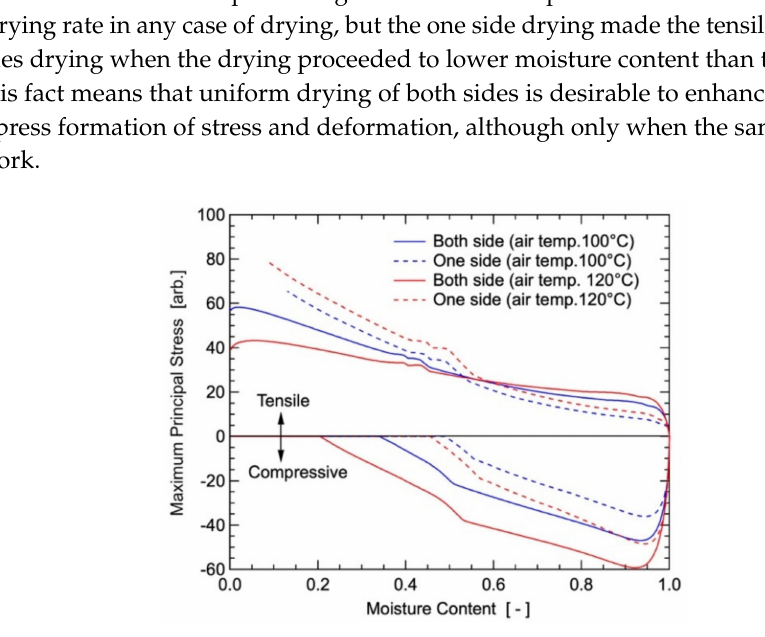
Figure 11. Maximum principal stresses against moisture content in sample with 1.0-mm thickness.